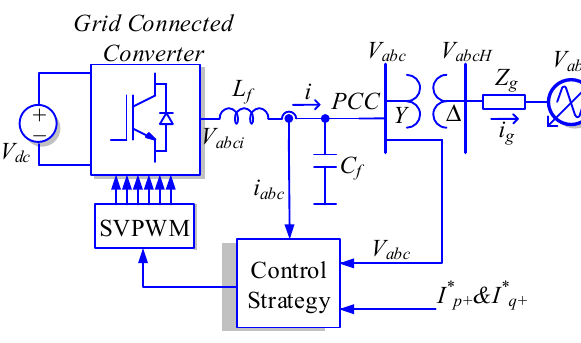
Figure 14. Schematic of the validation layout. Table 1. GC-VSC Parameters.